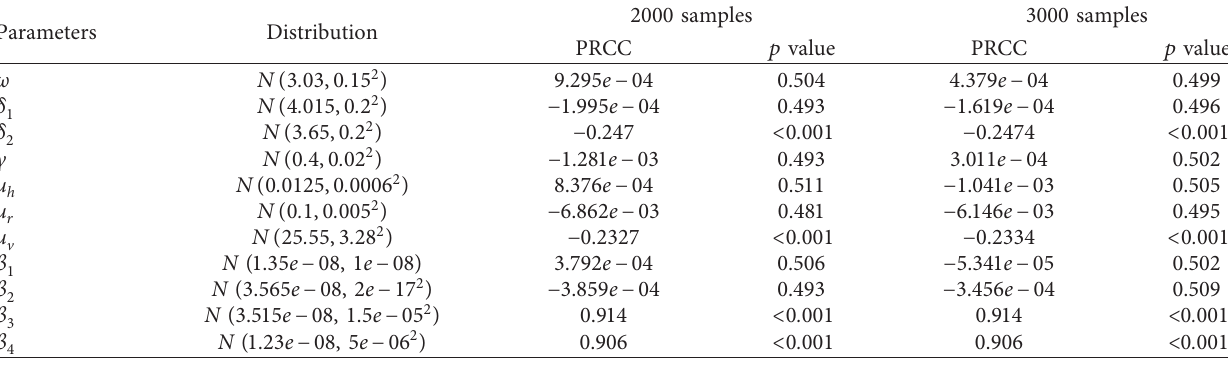
on each input parameter variable. 0